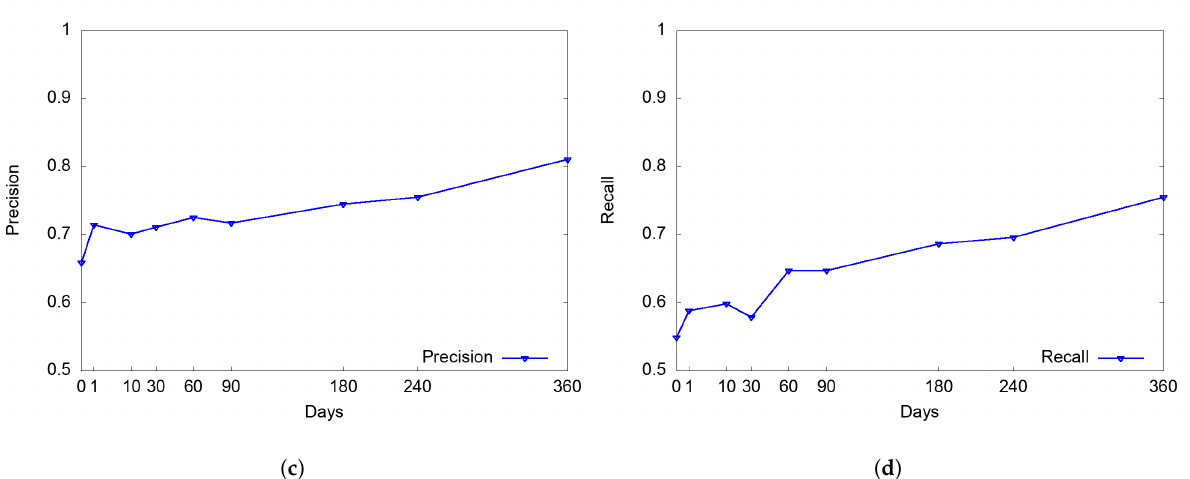
Figure 4. Estimated Average Classification Performance vs. Elapsed time (days). ( a ) Accuracy. ( b ) AUC. ( c ) Precision on Scams. ( d ) Recall on